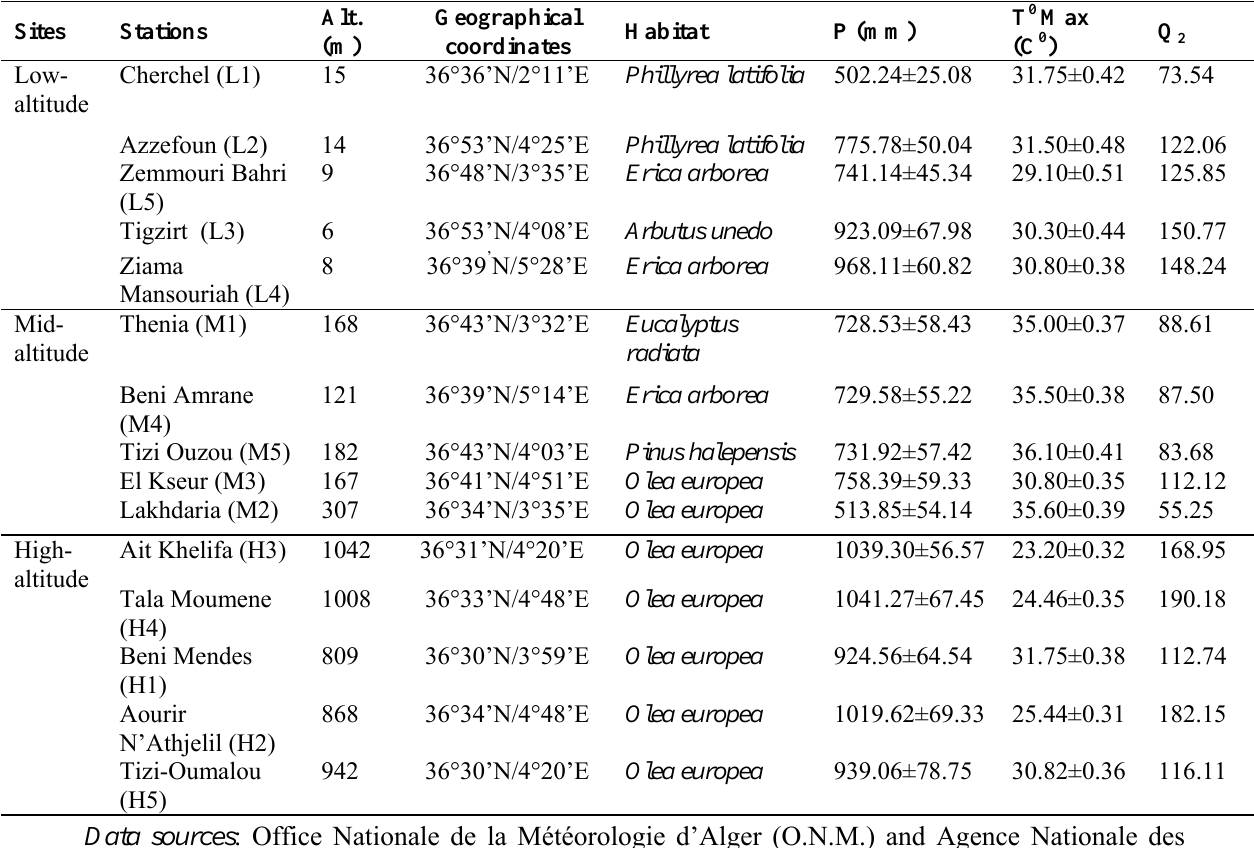
Table 3. Ecological factors of Pistacia lentiscus collection